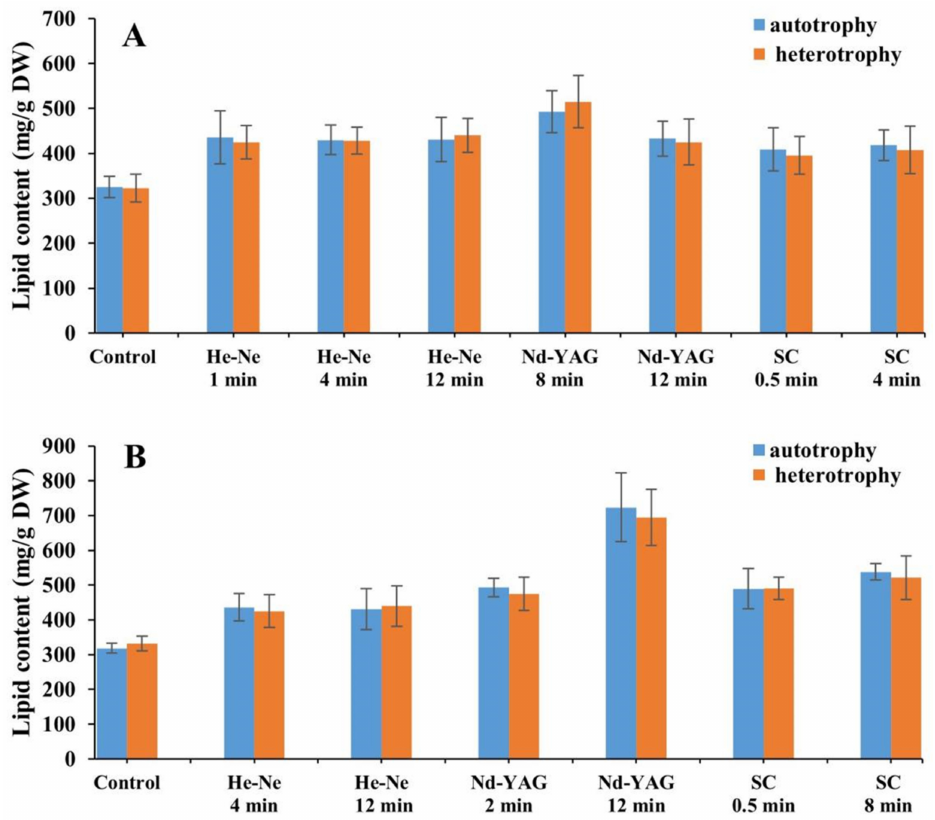
Figure 5. Lipid contents of laser mutants of Chlorella vulgaris strain FACHB 9 ( A ) and C. pyrenoidesa strain FACHB 31 ( B ) cultivated under autotrophic and heterotrophic